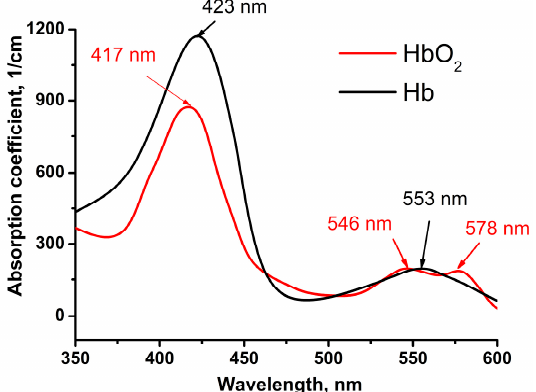
Figure 9. Absorption spectra of oxyhemoglobin (HbO 2 ) and deoxyhemoglobin (Hb). Spectra were calculated from the data presented in [39].